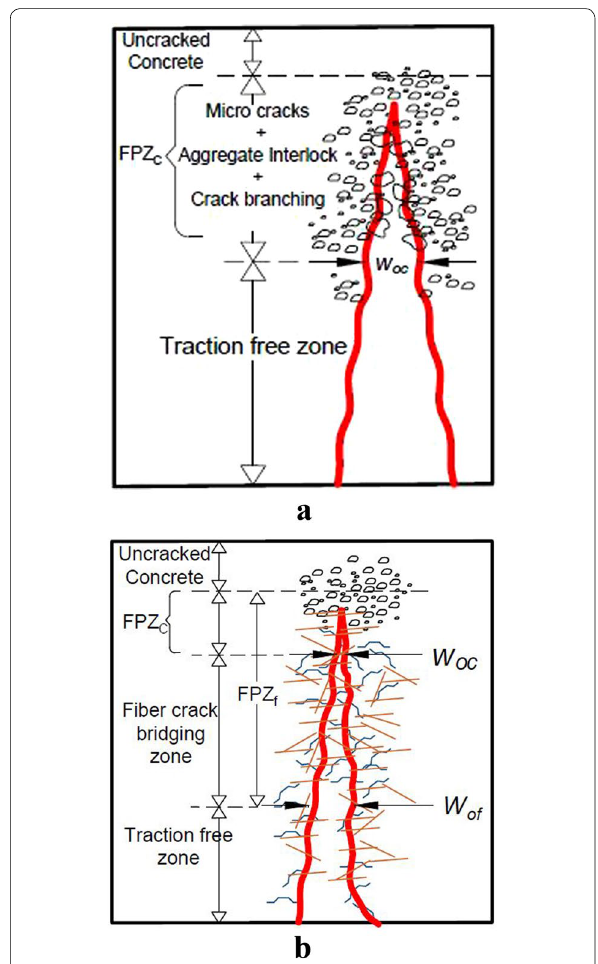
Fig. 1 Fracture mechanisms in Mode-I of a plain concrete and b fibre-reinforced